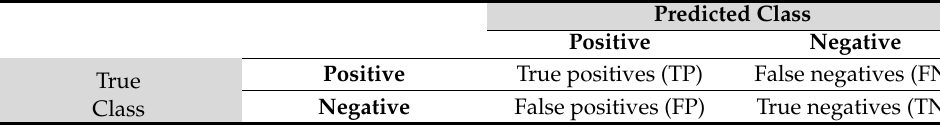
Table 3. Confusion matrix for binary